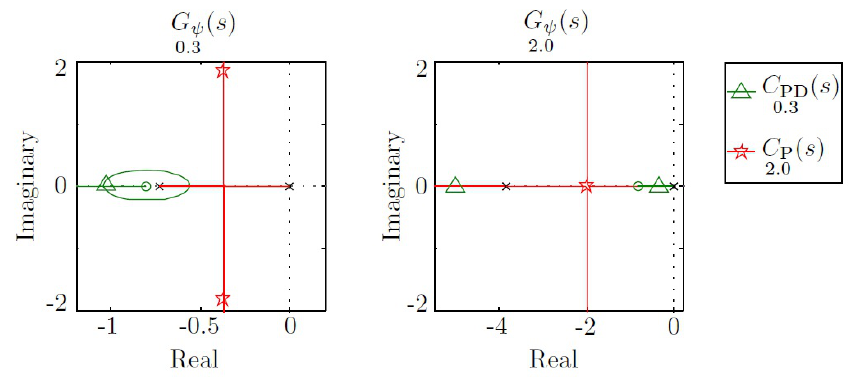
Figure 8. Root locus for G ψ 0.3 ( s ) and G ψ 2.0 ( s ) and pole displacement using controllers C PD 0.3 ( s ) and C P 2.0 ( s ) .